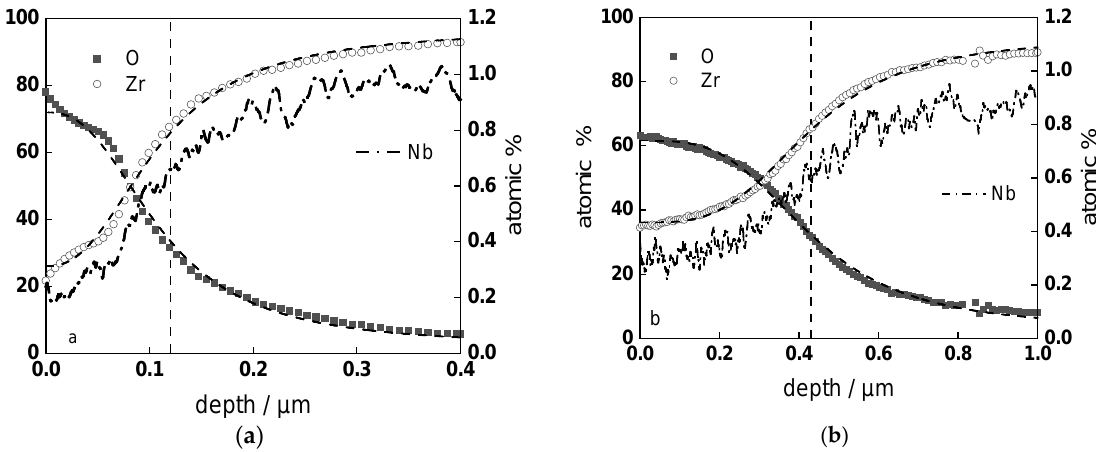
experimental data, solid lines-best-fit calculation. The legend gives oxidation time in h.